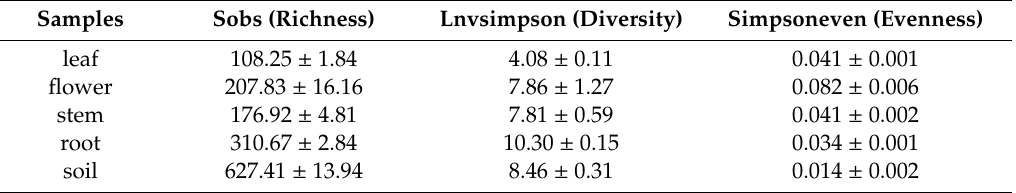
Table 1. Richness, diversity, and evenness indexes of fungal communities (mean ±